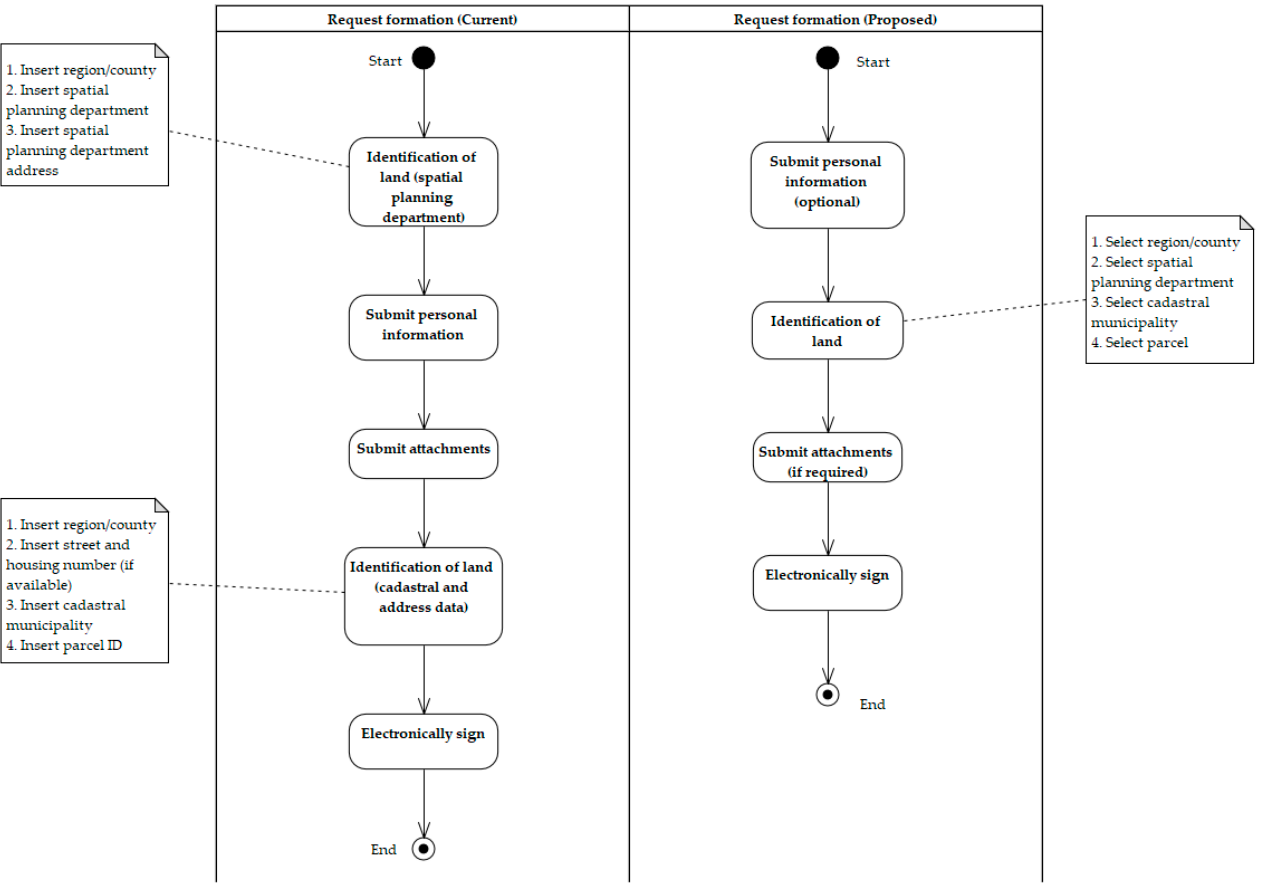
Figure 5. Request formation workflows. Source: Own compilation.